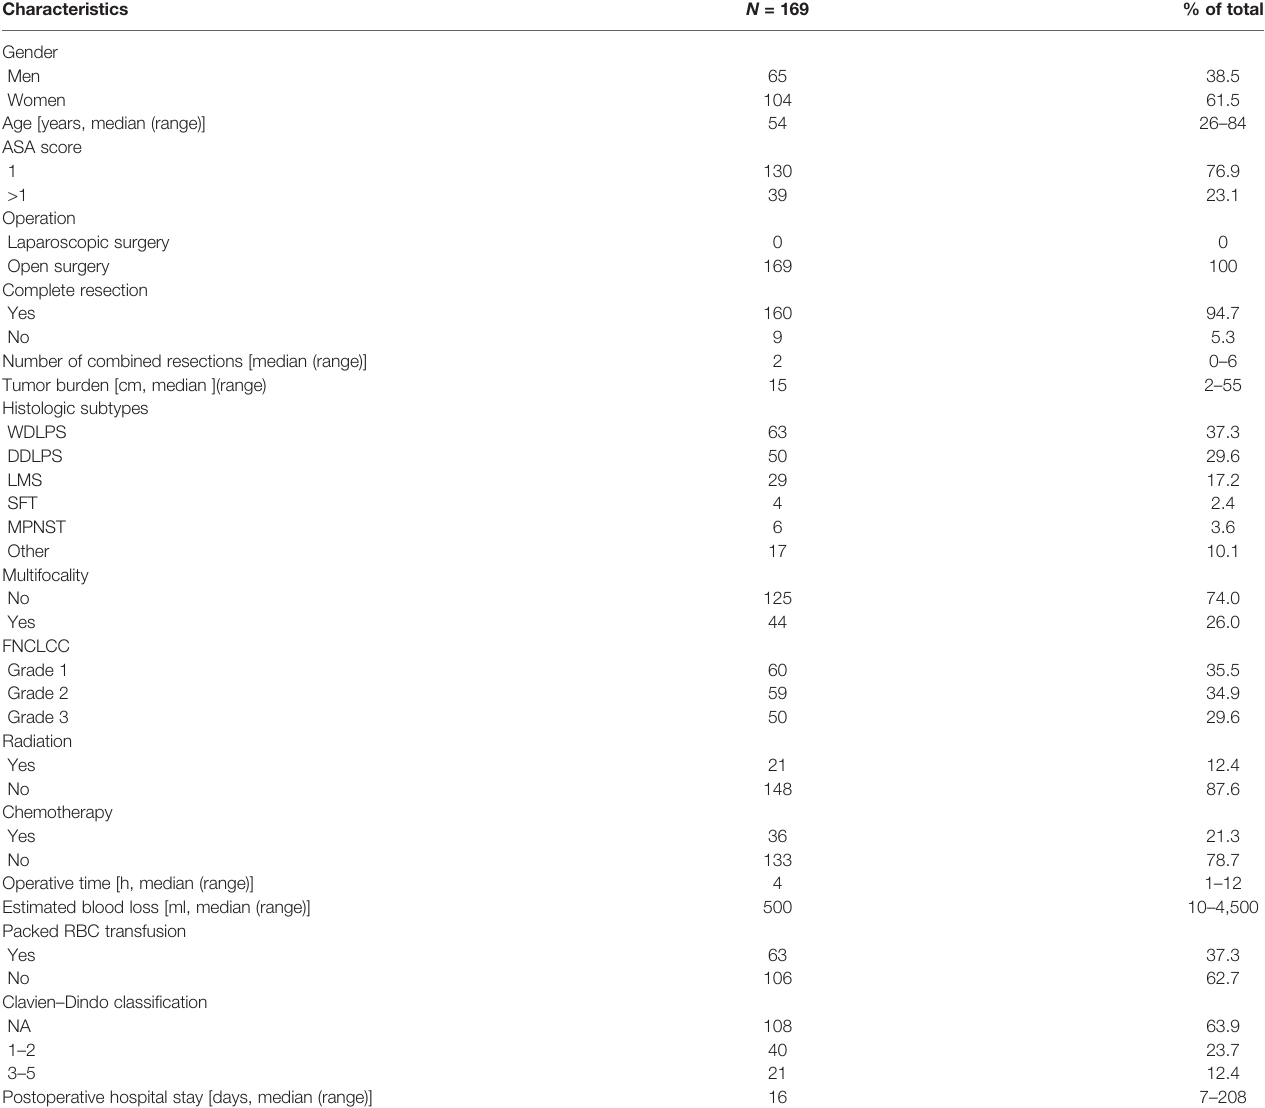
TABLE 2 | Patient and tumor characteristics in 169 patients with second surgery.